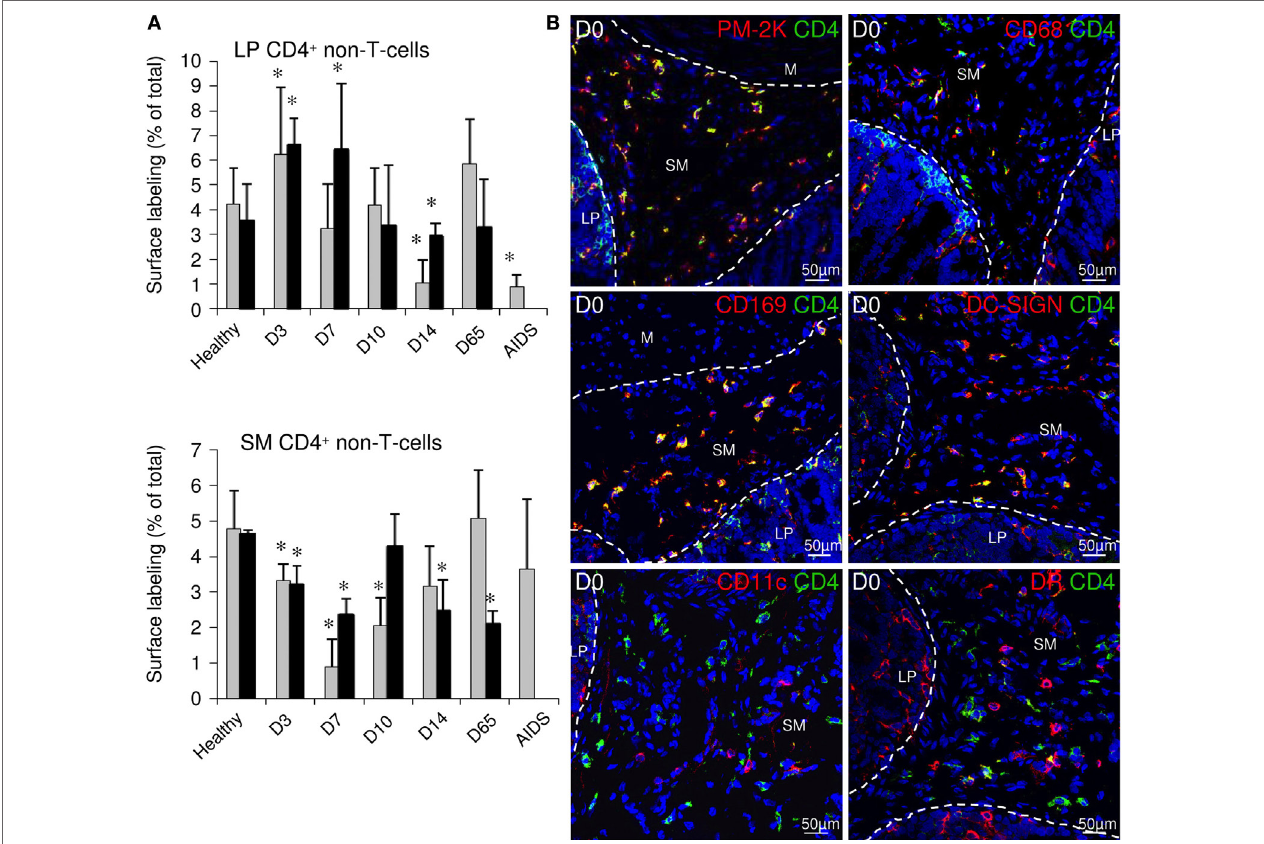
FigUre 6 | Quantification of the cD4 + non-T-cell subset in the lP and submucosa during simian immunodeficiency virus infection . (a) Ileal tissues sampled from healthy animals as well as from macaques euthanized at 3, 7, 10, 14, or 65 days post-SIV infection (two animals per time point), and from one animal presenting with AIDS-related symptoms, were labeled using anti-CD3 and anti-CD4 antibodies. The proportions of LP (top panel) or SM (bottom panel) tissues occupied by the CD3 − CD4 + labeled cells are represented as medians and SDs for each time point. For each animal, 5–10 independent areas, representing at least 1.5 mm 2 of LP or 1.4 mm 2 of SM, were quantified. Statistical analysis was performed for each infected macaque, compared individually to each healthy control. CD4 + non-T-cell subset was considered as over/under represented in one infected macaque if significantly different from both healthy controls, tested independently (* p < 0.05 as compared to each uninfected monkeys; Mann–Whitney two-tailed U test). (B) Representative examples of the ileum LP and submucosa of uninfected macaques colabeled with anti-CD4 monoclonal antibody (green) and anti-PM-2K, CD68, CD169/Siglec-1, DC-SIGN, CD11c, or MHC-II MamuLa-DR (DR) monoclonal antibodies (red). Nuclei are labeled in blue with DAPI. LP, lamina propria; SM, submucosa; M, muscular